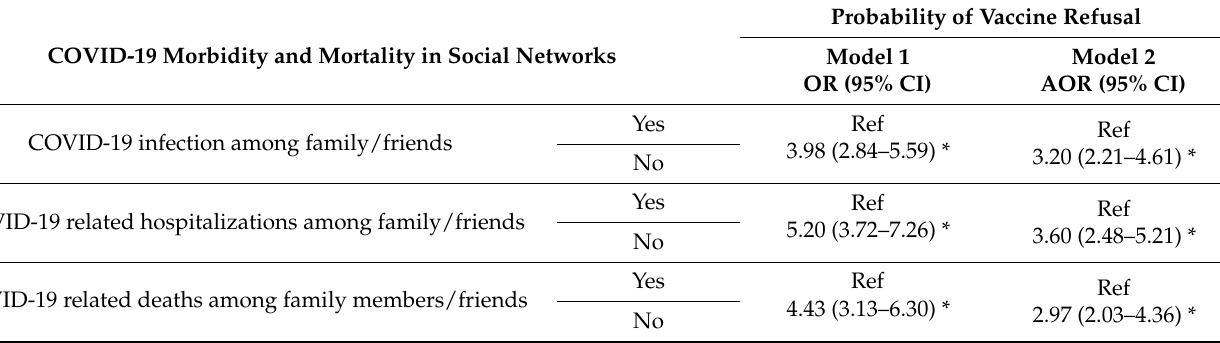
Table 2. Regression Analyses to Predict COVID-19 Vaccination Refusal Based on COVID-19 Exposure in Social Networks.